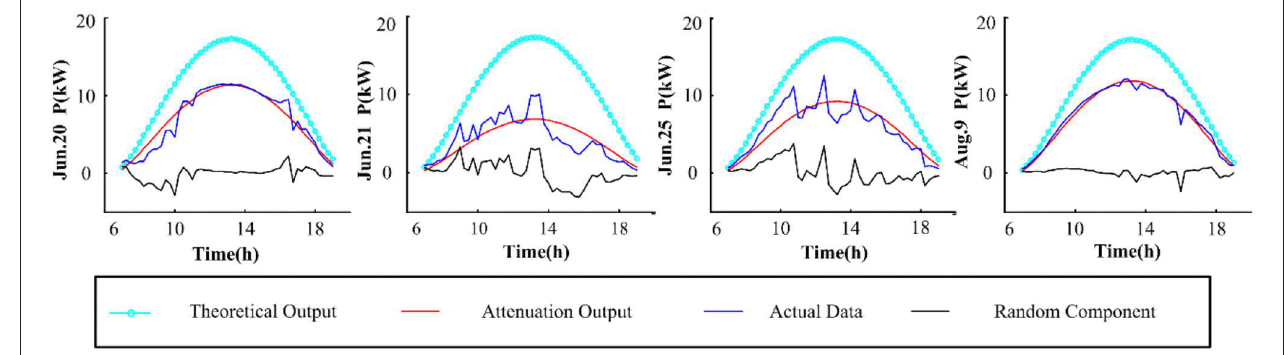
FIGURE 1 | Volatility output component